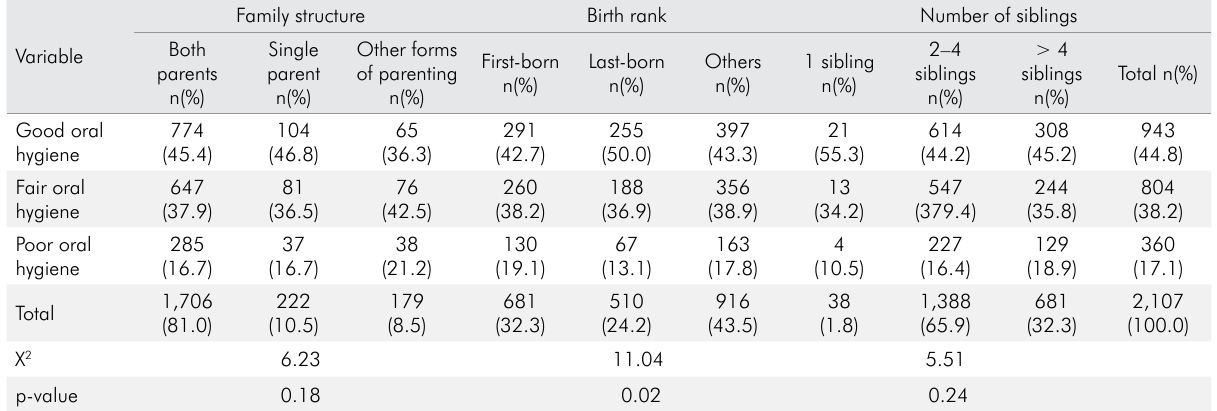
Family structure